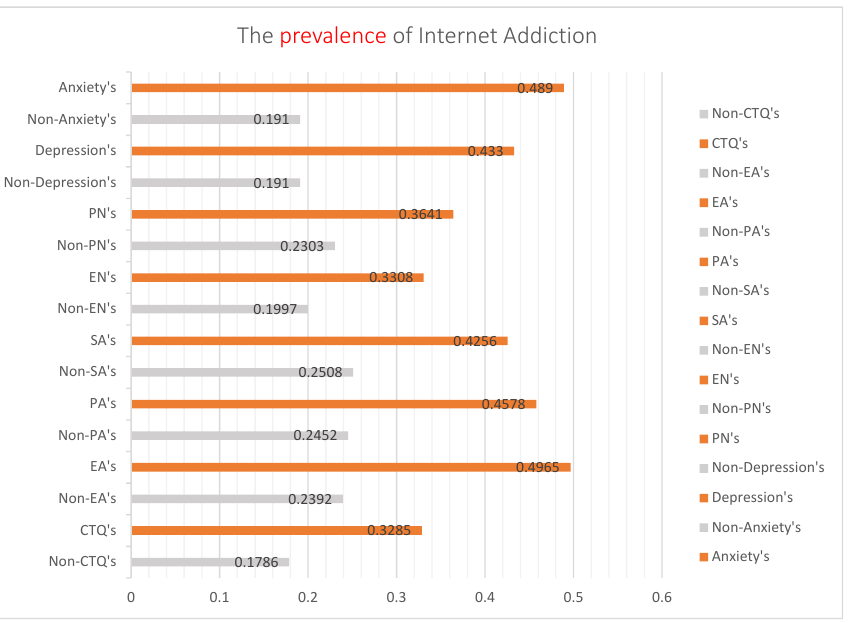
Figure 1. Cluster bar graph analysis of the prevalence of Internet addiction among adolescents with or without childhood trauma, anxiety, or depression. Note: Non-CTQ’s = None childhood trauma. CTQ’s = With childhood trauma. Non-EA’s = None emotion abuse. EA’s = With emotion abuse. Non-PA’s = None physical abuse. PA’s = With physical abuse. Non-SA’s = None Sexual abuse. SA’s = With Sexual abuse. Non-EN’s = None emotion neglect. EN’s = With emotion neglect. Non-PN’s = None physical neglect. PN’s = With physical neglect.